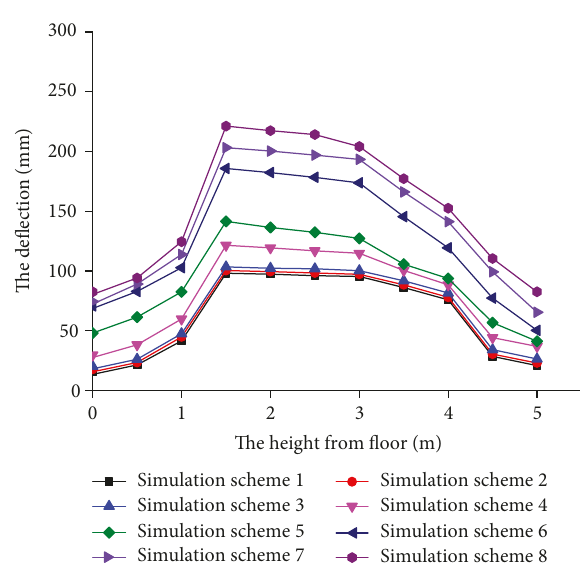
Figure 10: The de fl ection versus cutting width.